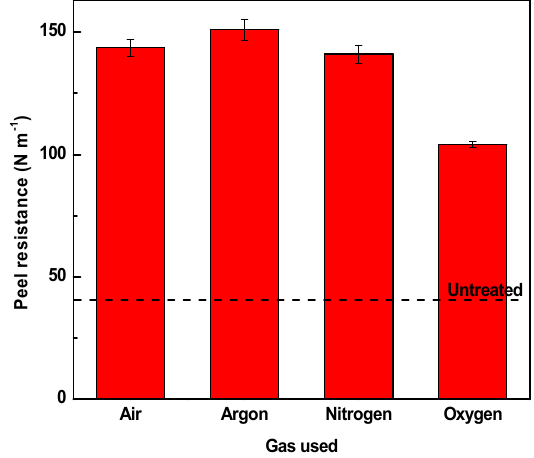
Figure 9. Peel resistance of LDPE treated for 120 s using different gases.